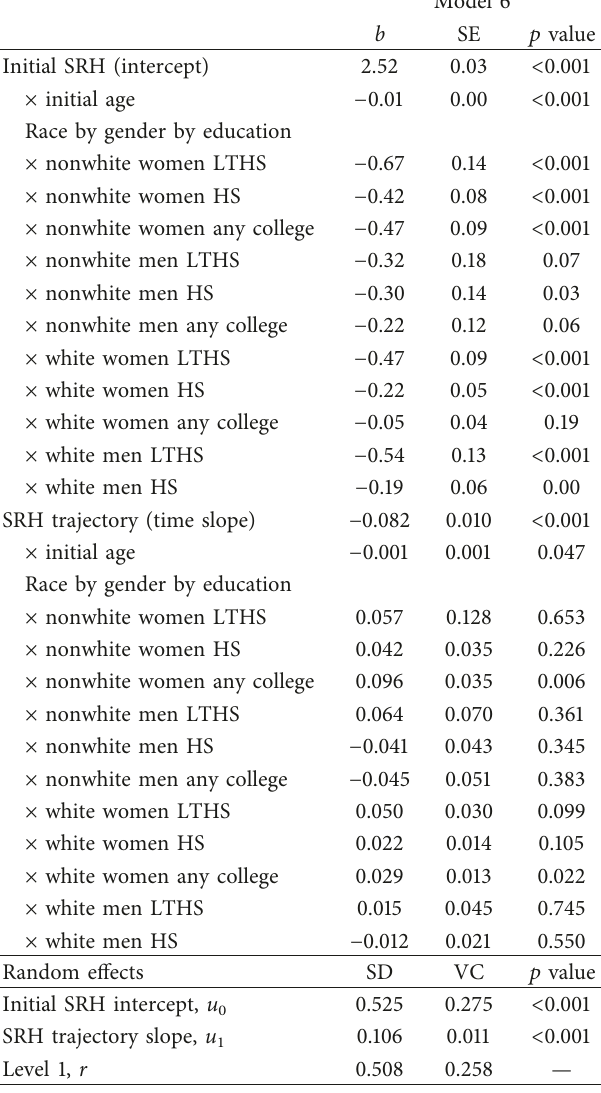
Table 5: Model 6: self-rated health trajectories by gender, race, and